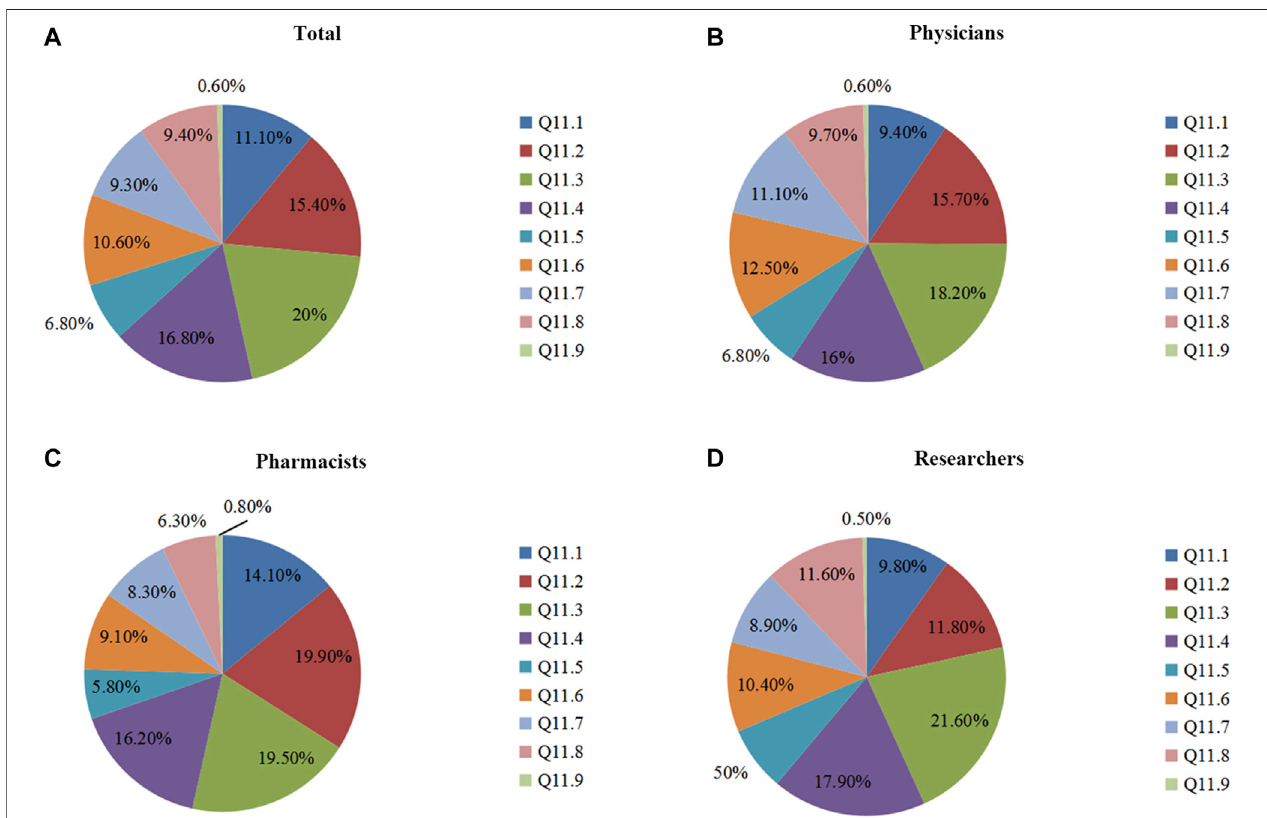
FIGURE3| The survey ofmajor in fl uencing factors ofPGx ’ sclinicalapplication. Figure 3A : Assessmentofallparticipants ’ understanding ofQ 11. Figures3B – D : Understanding of Q 11 by physicians, pharmacists, and researchers. Q11 In your opinion, which were three major in fl uencing factors of PGx ’ s clinical application (selecting three options)? 11.1 Not including into clinical detecting catalogue of National Health and Population Control Commission. 11.2 Lacking an application guideline of PGx speci fi cally for Chinese patients. 11.3 Lacking sector codes of PGx ’ s clinical application. 11.4 Lacking large-scaled clinical trials of PGx. 11.5 LackingapricingstandardforPGxDNAdetection.11.6LackingareportingstandardizationforPGxDNAdetection.11.7NotincludingPGxDNAdetectionintoNational Medical Insurance Scheme. 11.8 Not knowing PGx. 11.9 Miscellaneous?